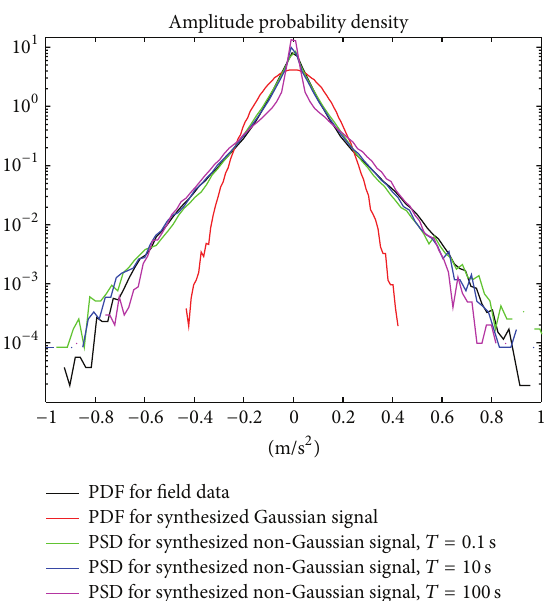
Figure 14: PDF for field data and synthesized data.